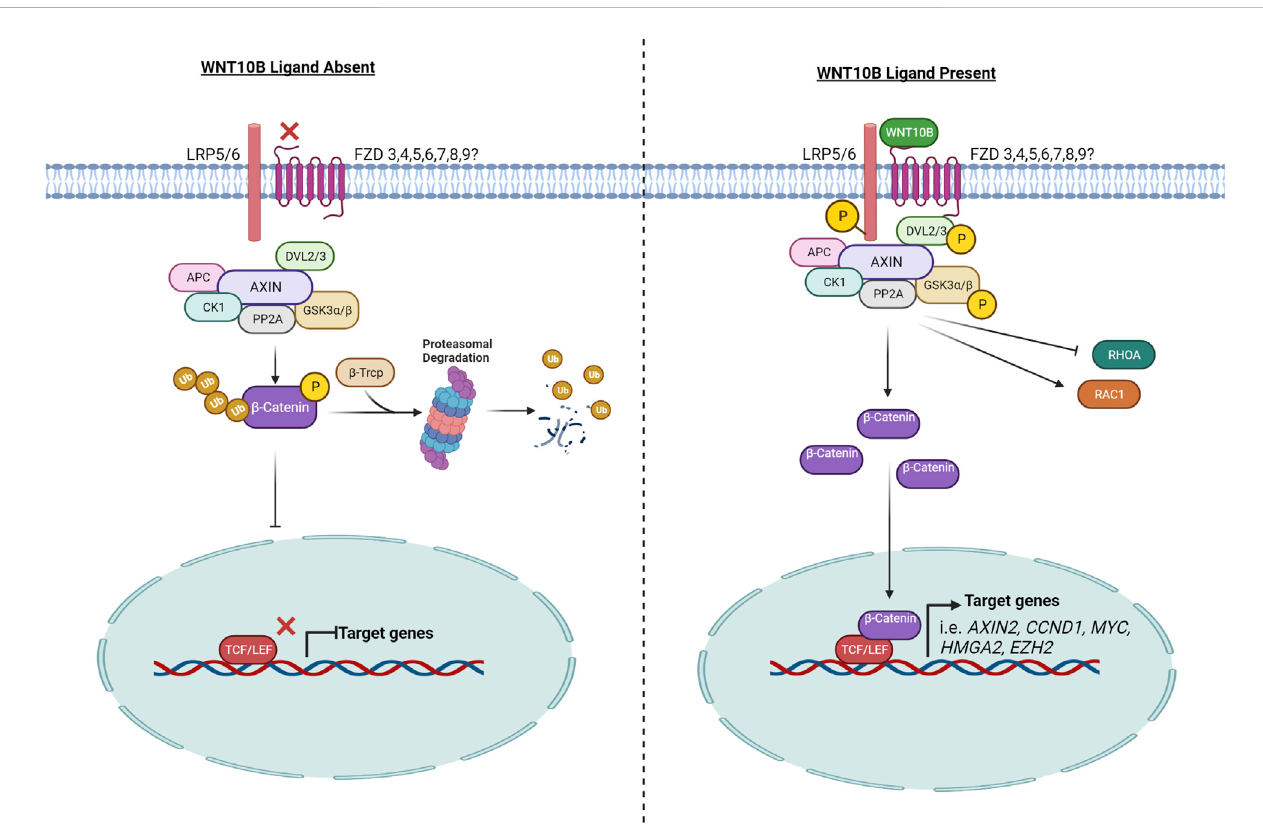
FIGURE 1 WNT10Bsignalingpathway.Theleftsideofthe fi gurerepresentsthesignalingpathwaywhenWNT10Bisabsentandthesignalingpathwayisoff.Theright side of the fi gure models the signaling pathway when WNT10B is present, following from receptor binding to target gene activation. P, phosphorylation; Ub, ubiquitination. Created with